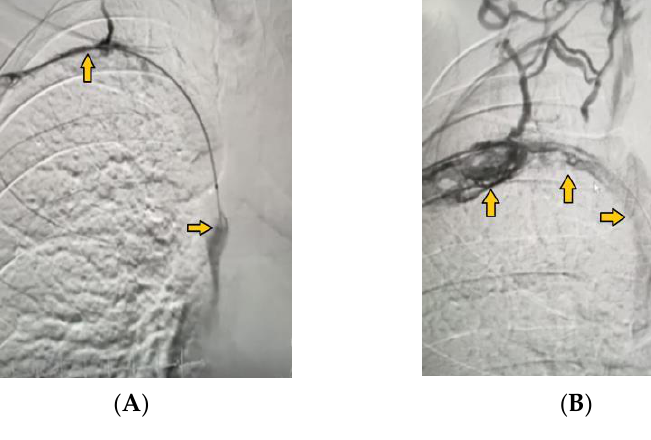
Figure 2. ( A ) Pharmaco-mechanical thrombolysis was performed using a catheter placed in the superior vena cava (yellow arrow) and subclavian vein (yellow arrow). ( B ) The outlined subclavian vein with residual thrombotic masses and stenosis due to organized fibrosis (yellow arrows). ( C ) Subclavian vein balloon dilatation causing the rupture of fibrotic masses (yellow arrows).